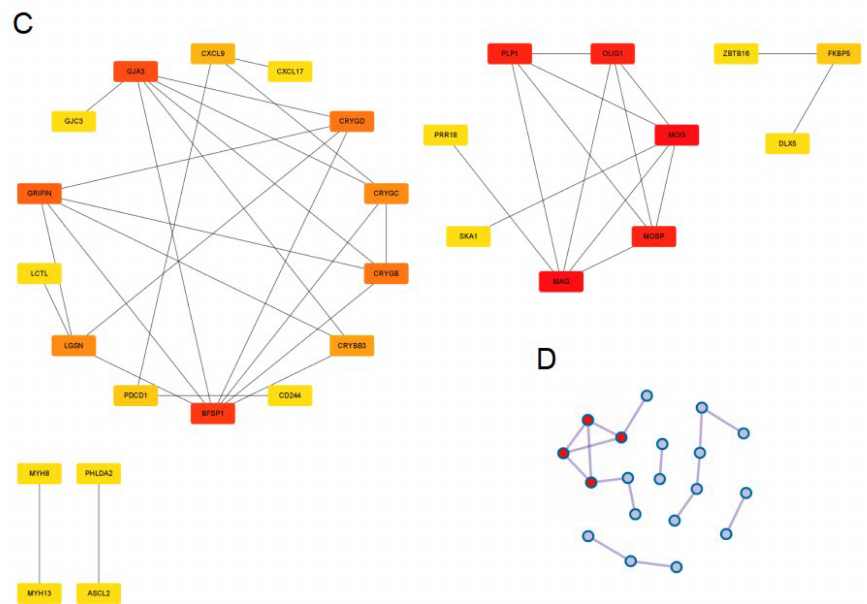
Figure 4. PPI network of DEGs. ( A ). PPI network of up-regulating DEGs;The redder gene represented the higher rank. ( B ). Densely connected gene sets in up-regulating DEGs. ( C ). PPI network of down- regulating DEGs. ( D ). Densely connected gene sets in down-regulating DEGs.